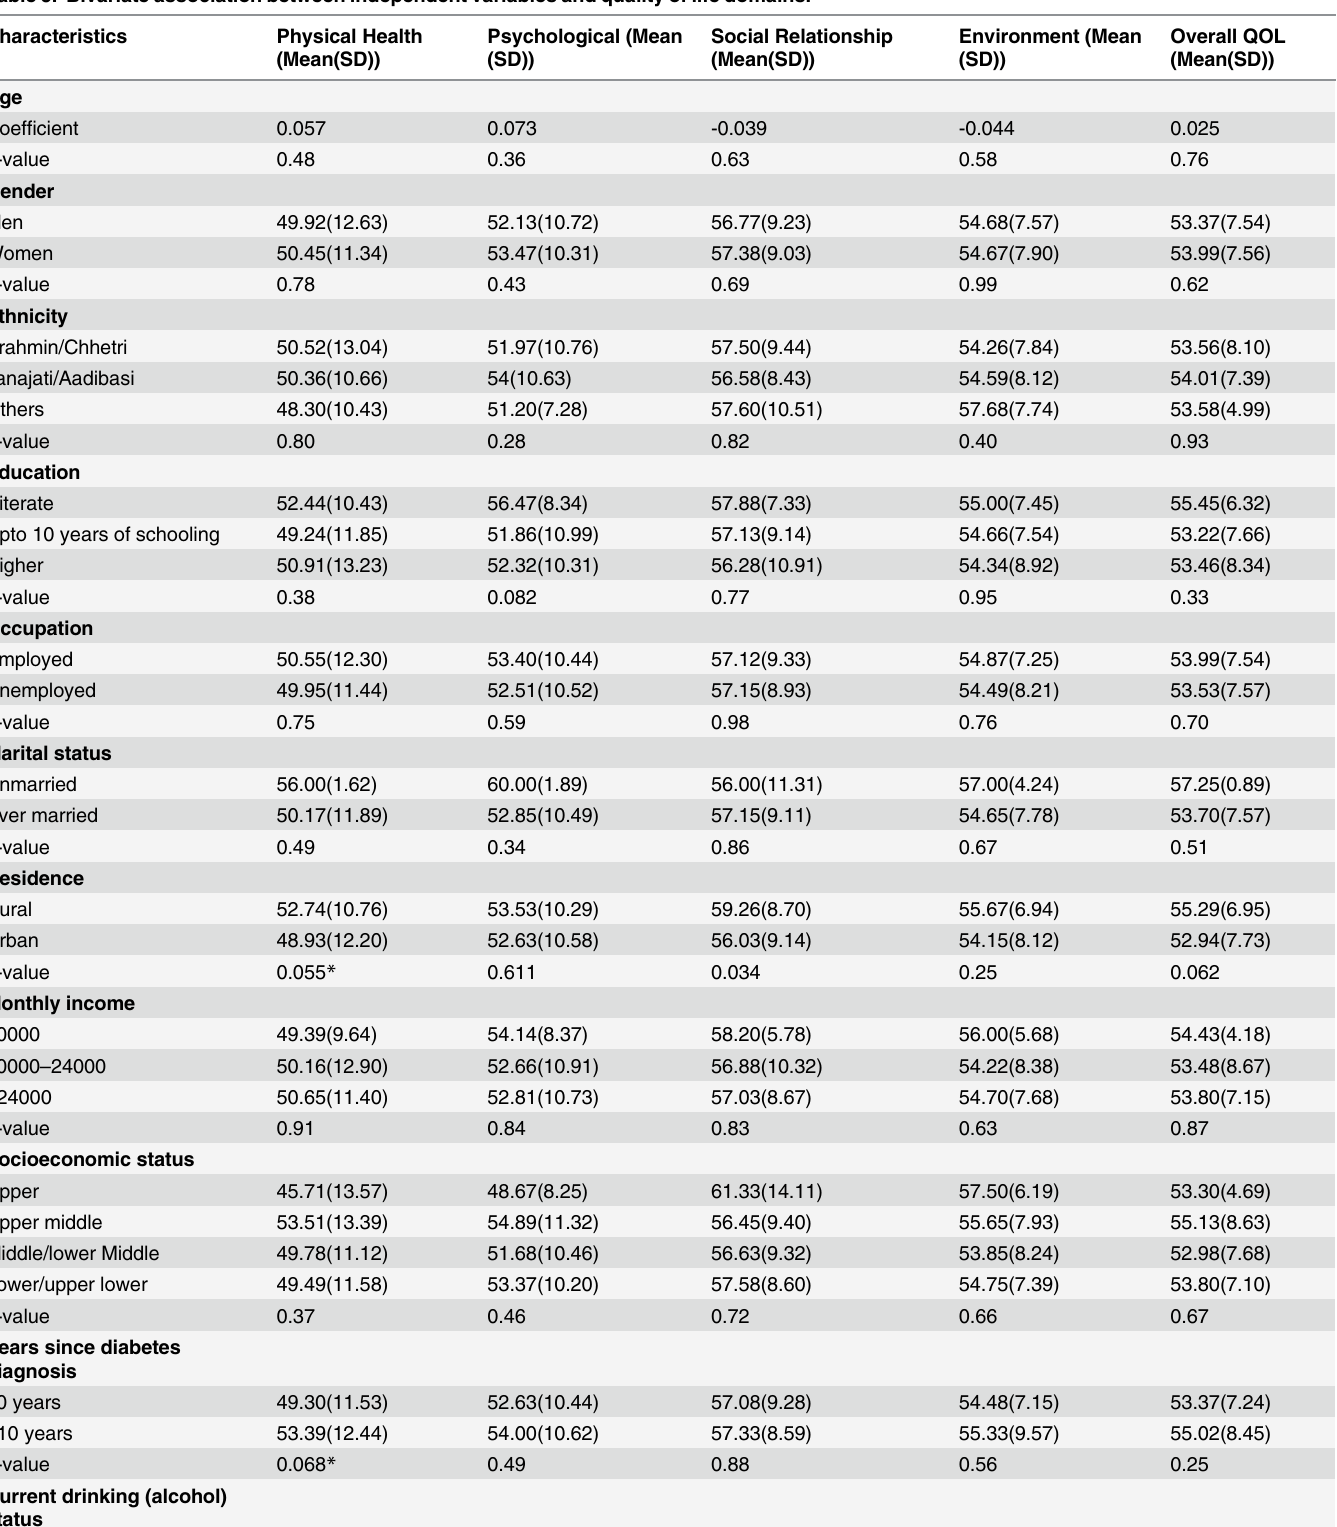
Table 5. Bivariate association between independent variables and quality of life